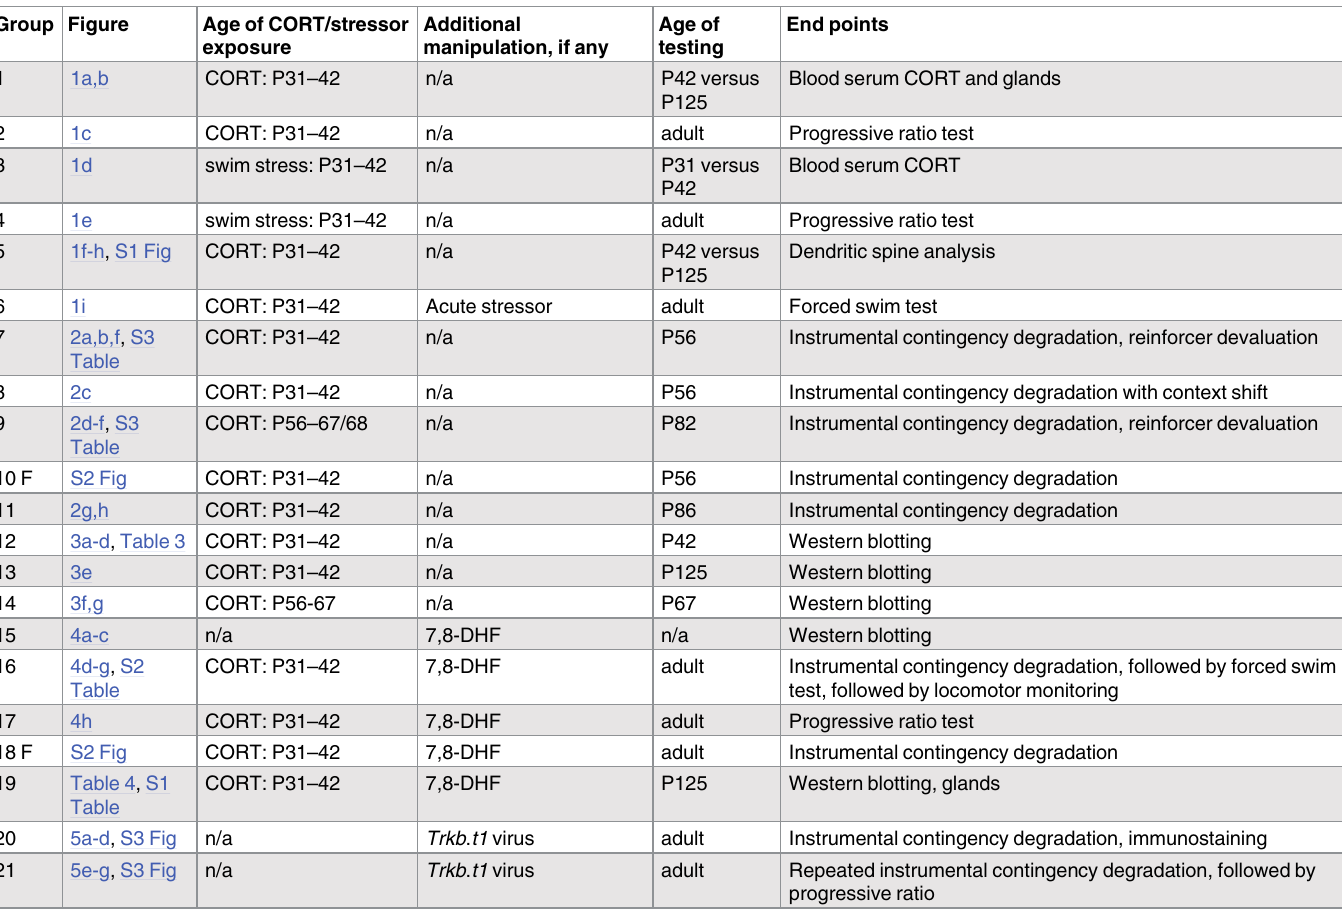
Table 1. List of experiments. A summary of experiments reportedin this manuscriptis provided, with corresponding figure numbers. “Adult” refers to testing completedbetween8–12 wk of age. Group Figure